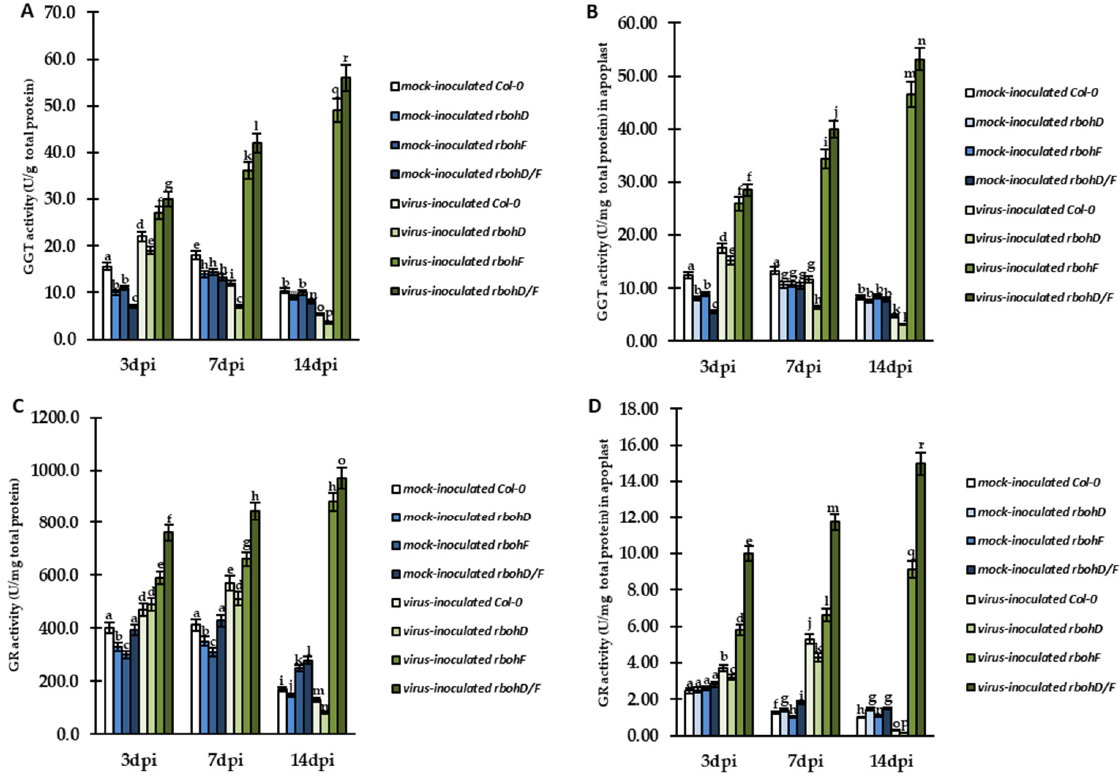
Figure 9. Cellular and apoplastic activity of GGT ( A , B ) and GR ( C , D ) in the leaves of TuMV- and mock-inoculated Col-0, rbohD , rbohF , and rbohD/F plants between 3 and 14 dpi. The mean activities (in U/mg total protein) were calculated and analyzed by ANOVA and Tukey’s HSD test at p < 0.05. Statistically signi fi cant values are indicated by di ff erent le tt ers above the bars. Further validation of GST (Figure 10A) and GPXL (Figure 10B) activity was also per- formed. In general, the pa tt ern of GST activity changes was quite similar to that of GR in cell. Plants showing susceptibility (Col-0)/enhanced susceptibility ( rbohD ) during interac- tion with TuMV had slightly upregulated GST between 3 and 7 dpi (Figure 10A). In the virus-inoculated rbohD plants, the activity of GST was lower than in Col-0 (Figure 10A). After 7 dpi, GST activity was downregulated in Col-0 and rbohD plants, especially in the la tt er, in which reduction was 4-fold. In contrast, plants showing resistance ( rbohF ) and enhanced resistance ( rbohD/F ) were characterized by increased activity of GST between 3 and 14 dpi (Figure 10A). The induction of enzymatic activity was the highest (2.12-fold) in rbohD/F plants during TuMV interaction. GPXL was upregulated in Col-0 and rbohD plants inoculated with TuMV between 3 and 14 dpi, by 1.55-fold and 1.72-fold, respec- tively (Figure 10B). In turn, GPXL activity was downregulated between 3 and 14 dpi in rbohF – and rbohD/F –TuMV interaction by 2.77-fold and 5.33-fold, respectively.